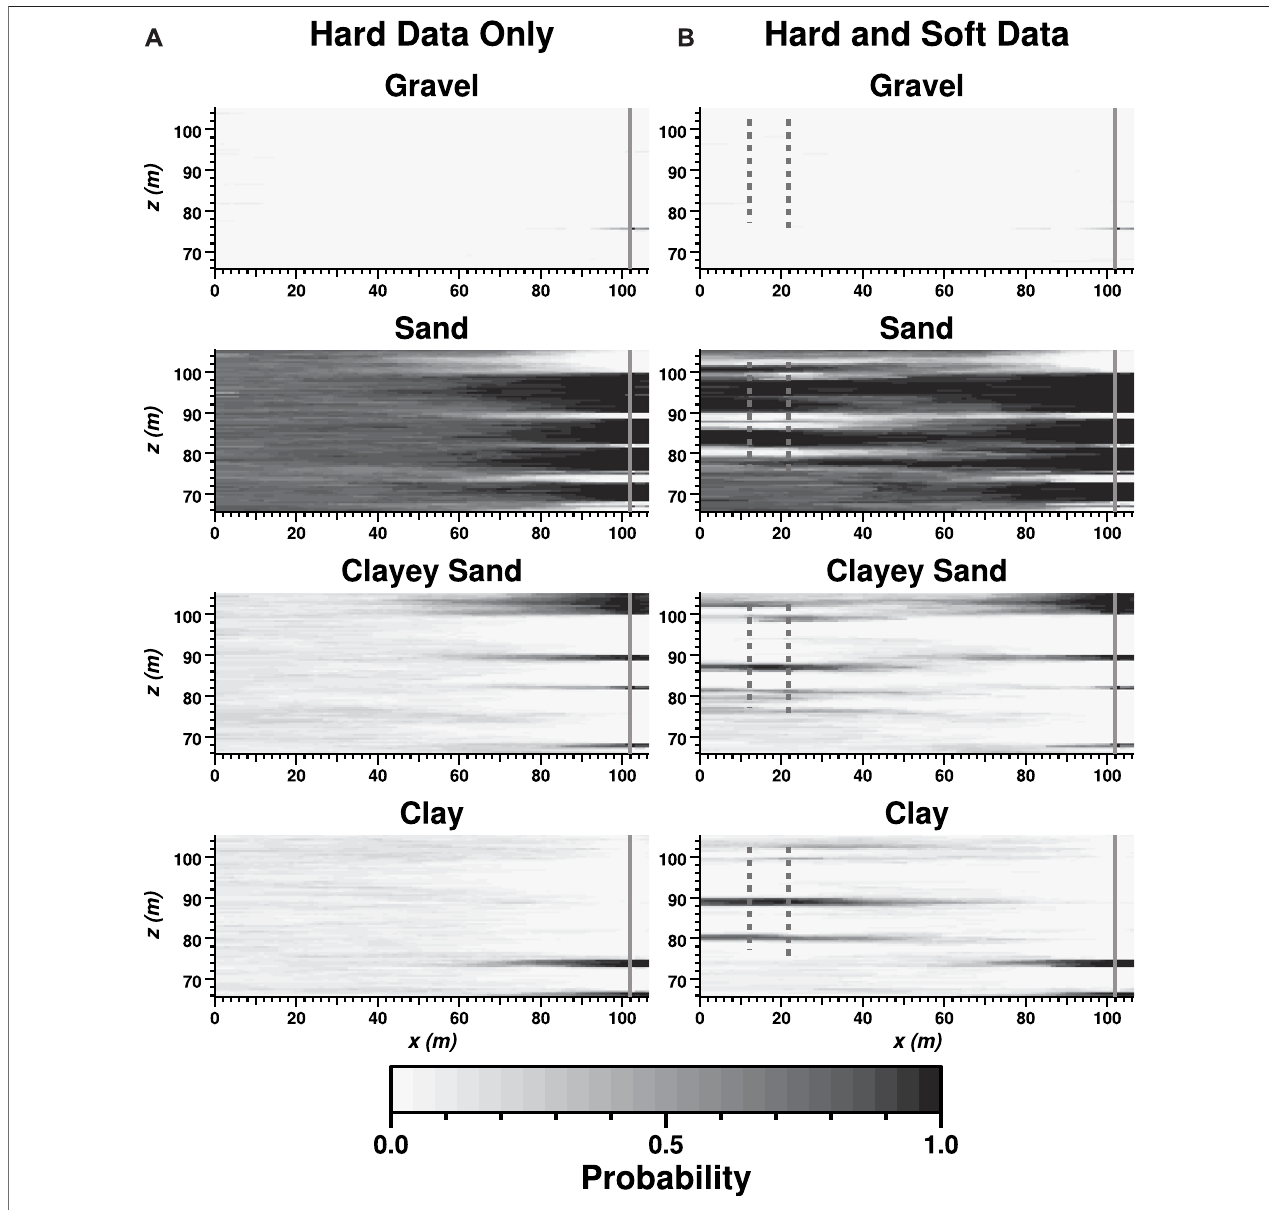
FIGURE4| Mapsofprobabilityofoccurrenceforeach lithofacies,basedonmeanindicatorvalueof100realizations, forcases with (A) harddataonly and (B) hard and soft data (soft data hardness (cid:2) 0.8).